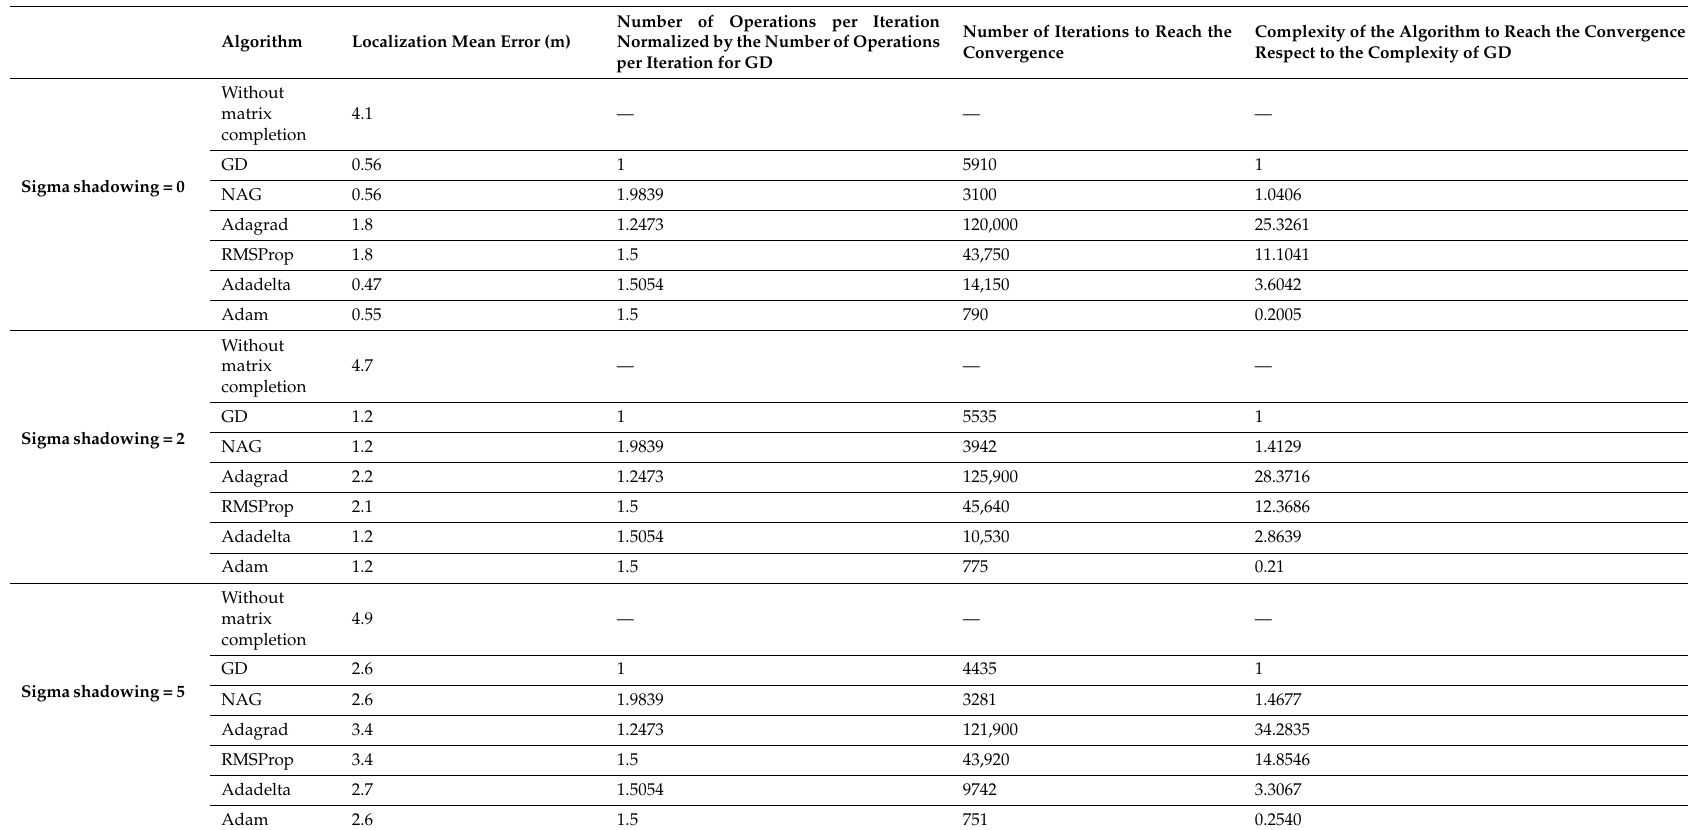
Table 3. Algorithms’ complexity normalized with respect to ‘Gradient descent’